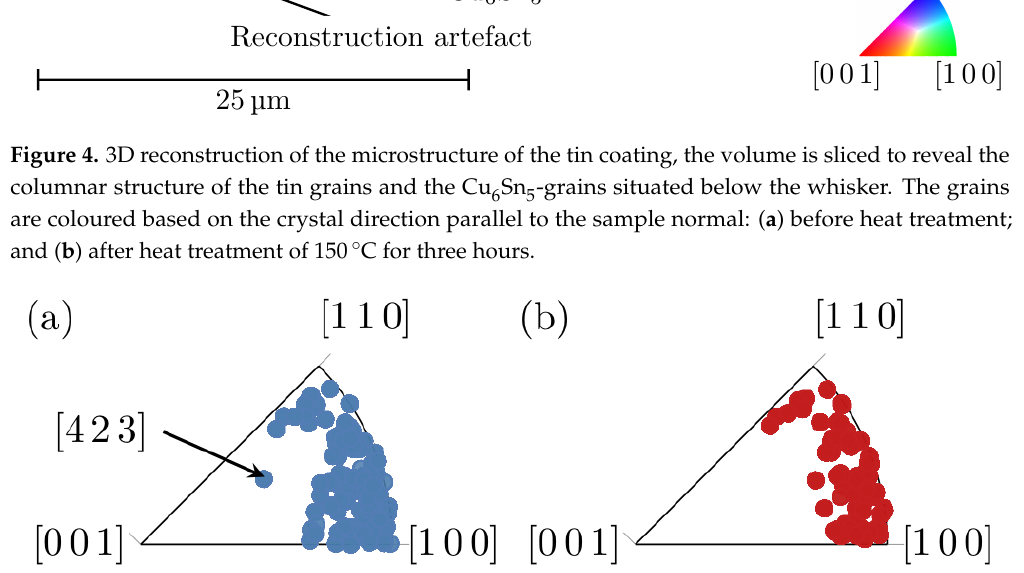
Figure 5. Inverse pole figure showing the crystal orientation parallel to the z -axis (sample normal). For reference to the coordinate system see Figure 2. The black arrow marks an orientation which is not present after the heat treatment: ( a ) before heat treatment; and ( b ) after heat